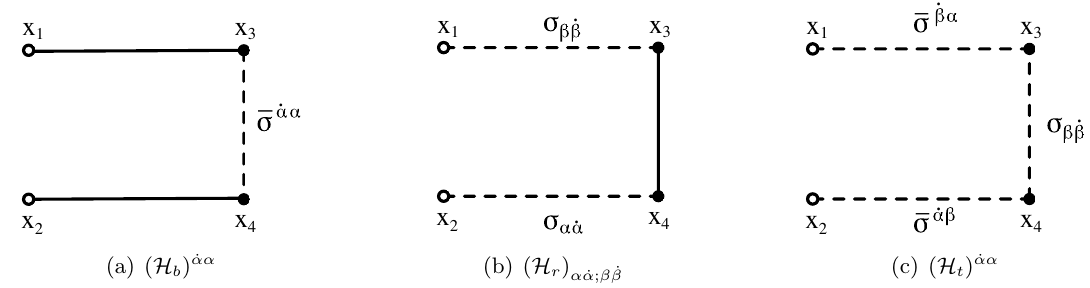
Figure 14 . The kernels associated to the Hamiltonian graph-building operators ^ H F involved in the computation of the four-point function G with j = 1 ; 2 ; 3. White dots represent external (cid:30) 1 (cid:30) y 2 points and black dots | integration over the full space R 4